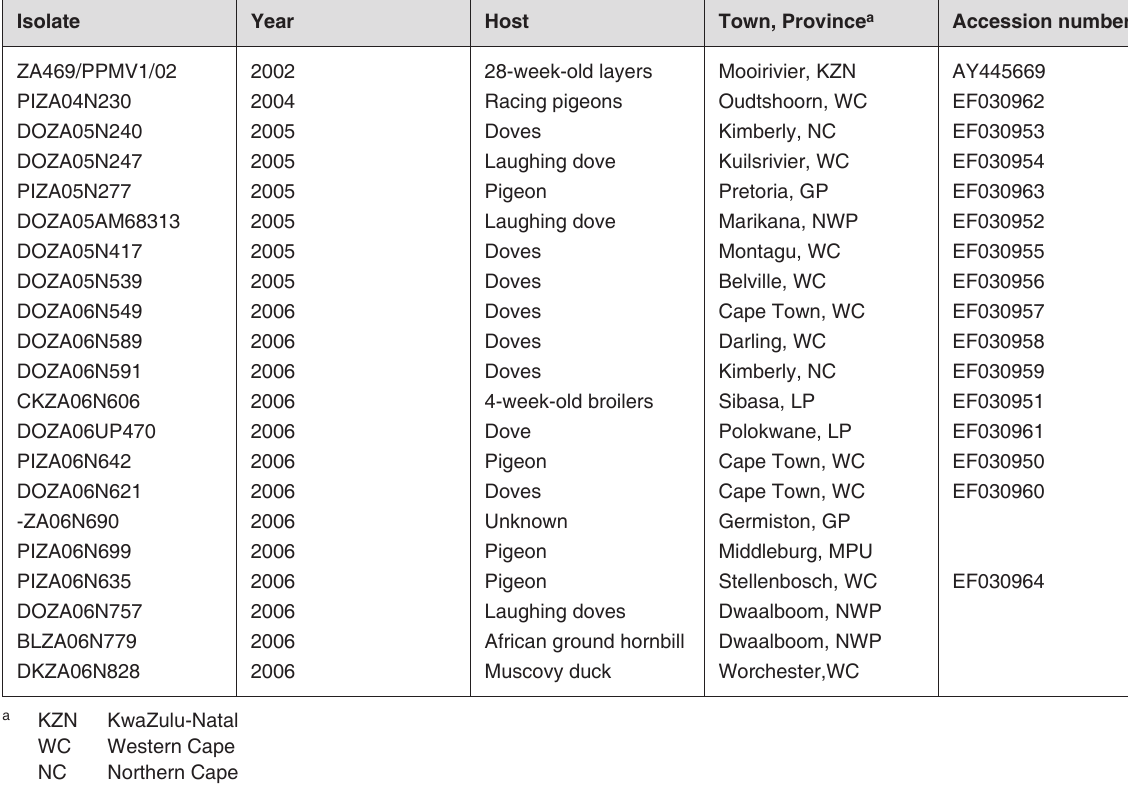
TABLE 1 South African pigeon paramyxovirus isolates